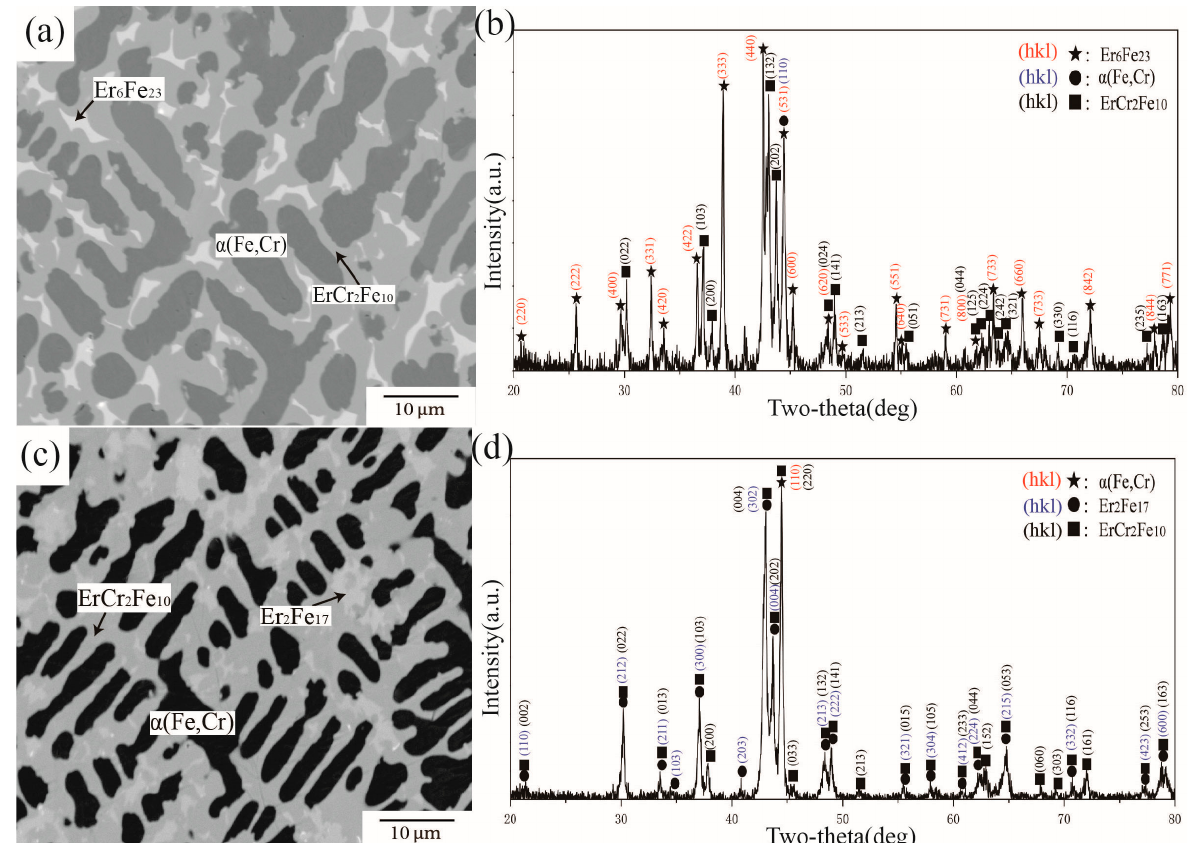
Figure 15. ( a ) BSE image of alloy C9, ( b ) XRD result of alloy C9, ( c ) BSE image of alloy C11, ( d ) XRD result of alloy C11.